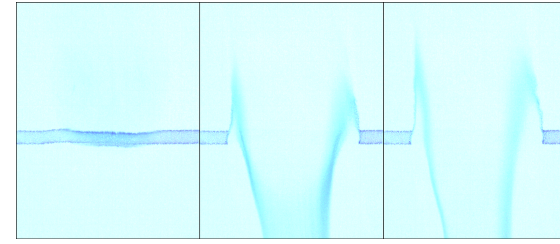
Figure 9: Water droplet – The three images are sep- arated by 1 s. The real size of the images is 20 mm width. On the left, a line of blue methyl was drawn. The droplet came from the top and crossed the line. On the side of the wake we can see that the blue coloring went upwards. The angle of inclination was 30 ◦ and the volume of the droplet 75 µ